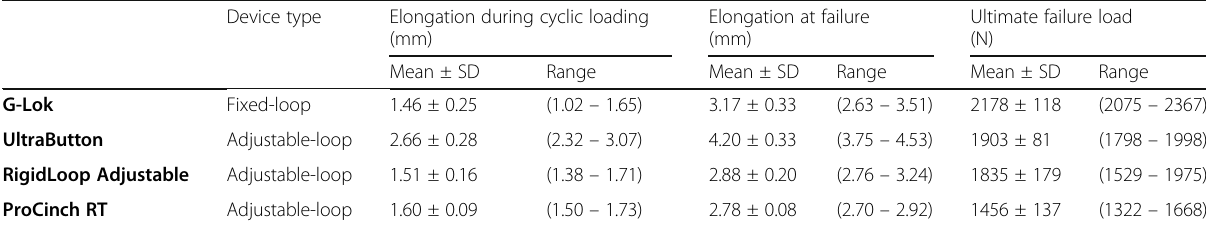
Table 1 Elongation and load data for all cortical suspension devices Device